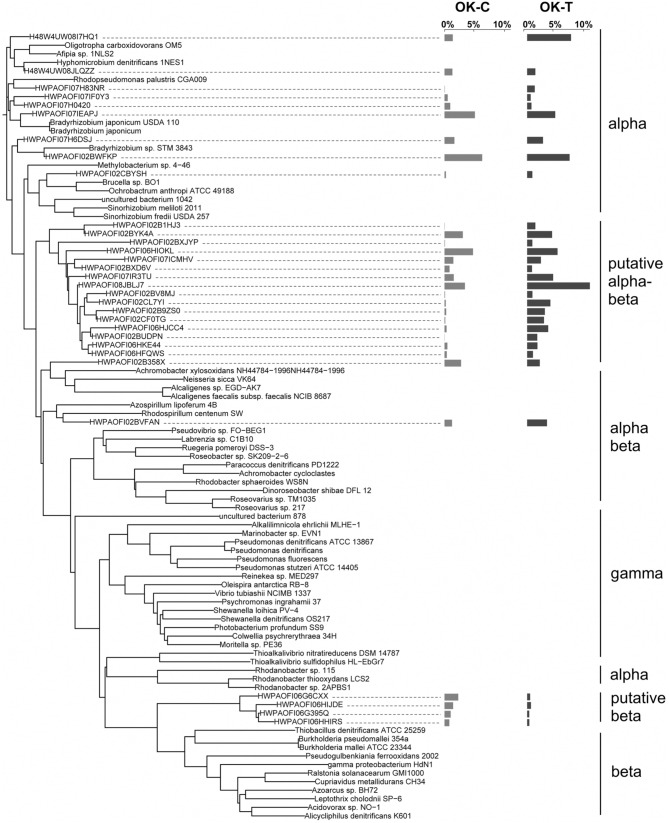
NosZ neighbor-joining tree based on amino acid sequences showing the most abundant 31 OTU representative sequences from Oklahoma control (OK-C) and warming (OK-T) with reference sequences. Tree is based on forward reads only. The OTUs shown contain 41.6% of sequences in OK-C and 86.9% of the sequences in OK-T. The average relative abundances are represented by bar graphs to the right of the OTU. The first column corresponds to OK, the second to AK.